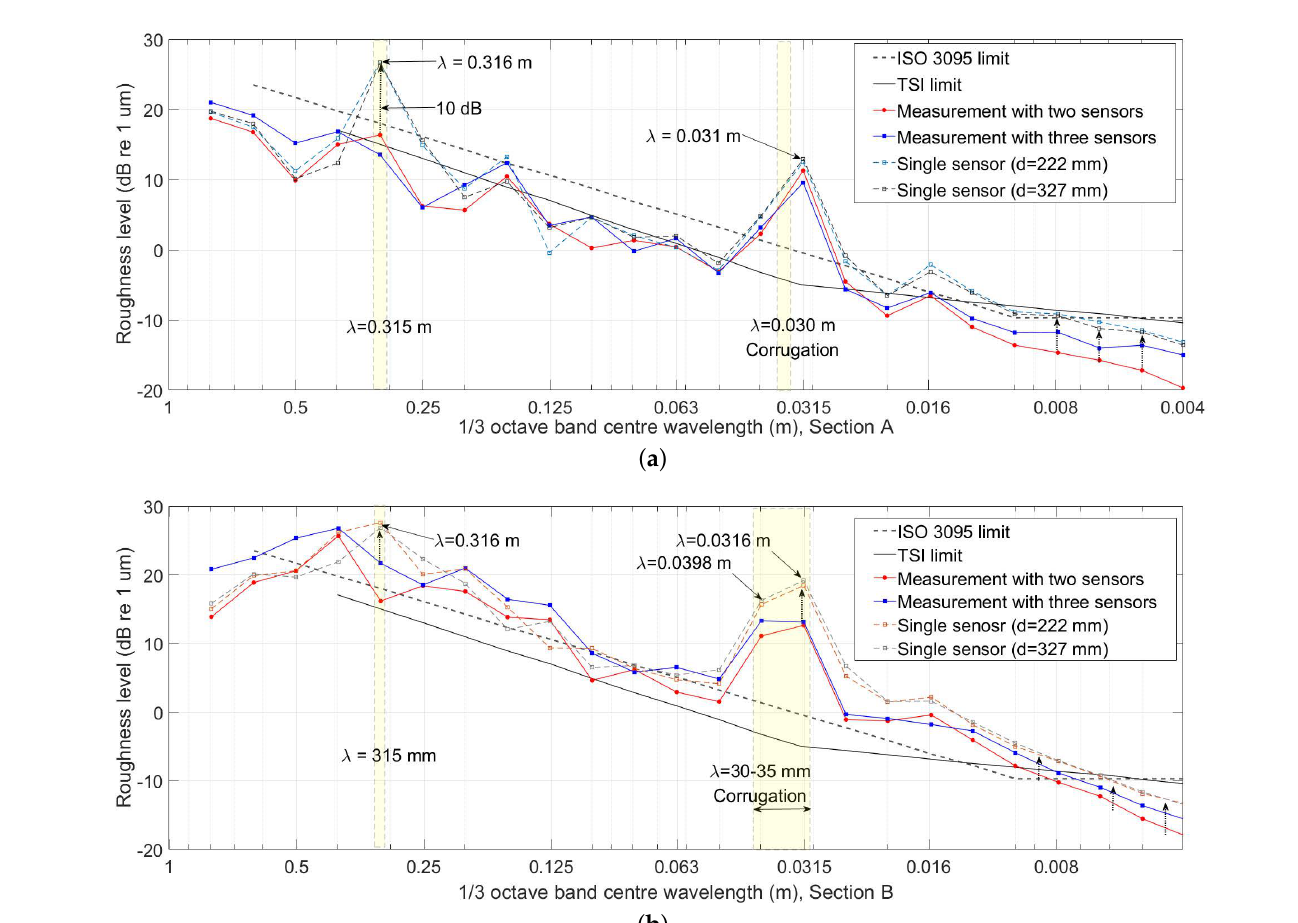
Figure 7. Sensor measurement values of rail surface roughness at operational field track sections.